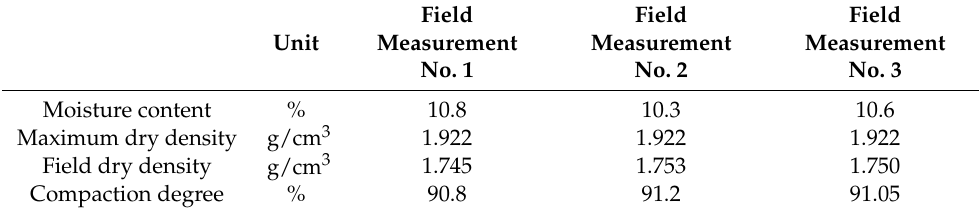
Table 3. Field density measurement test